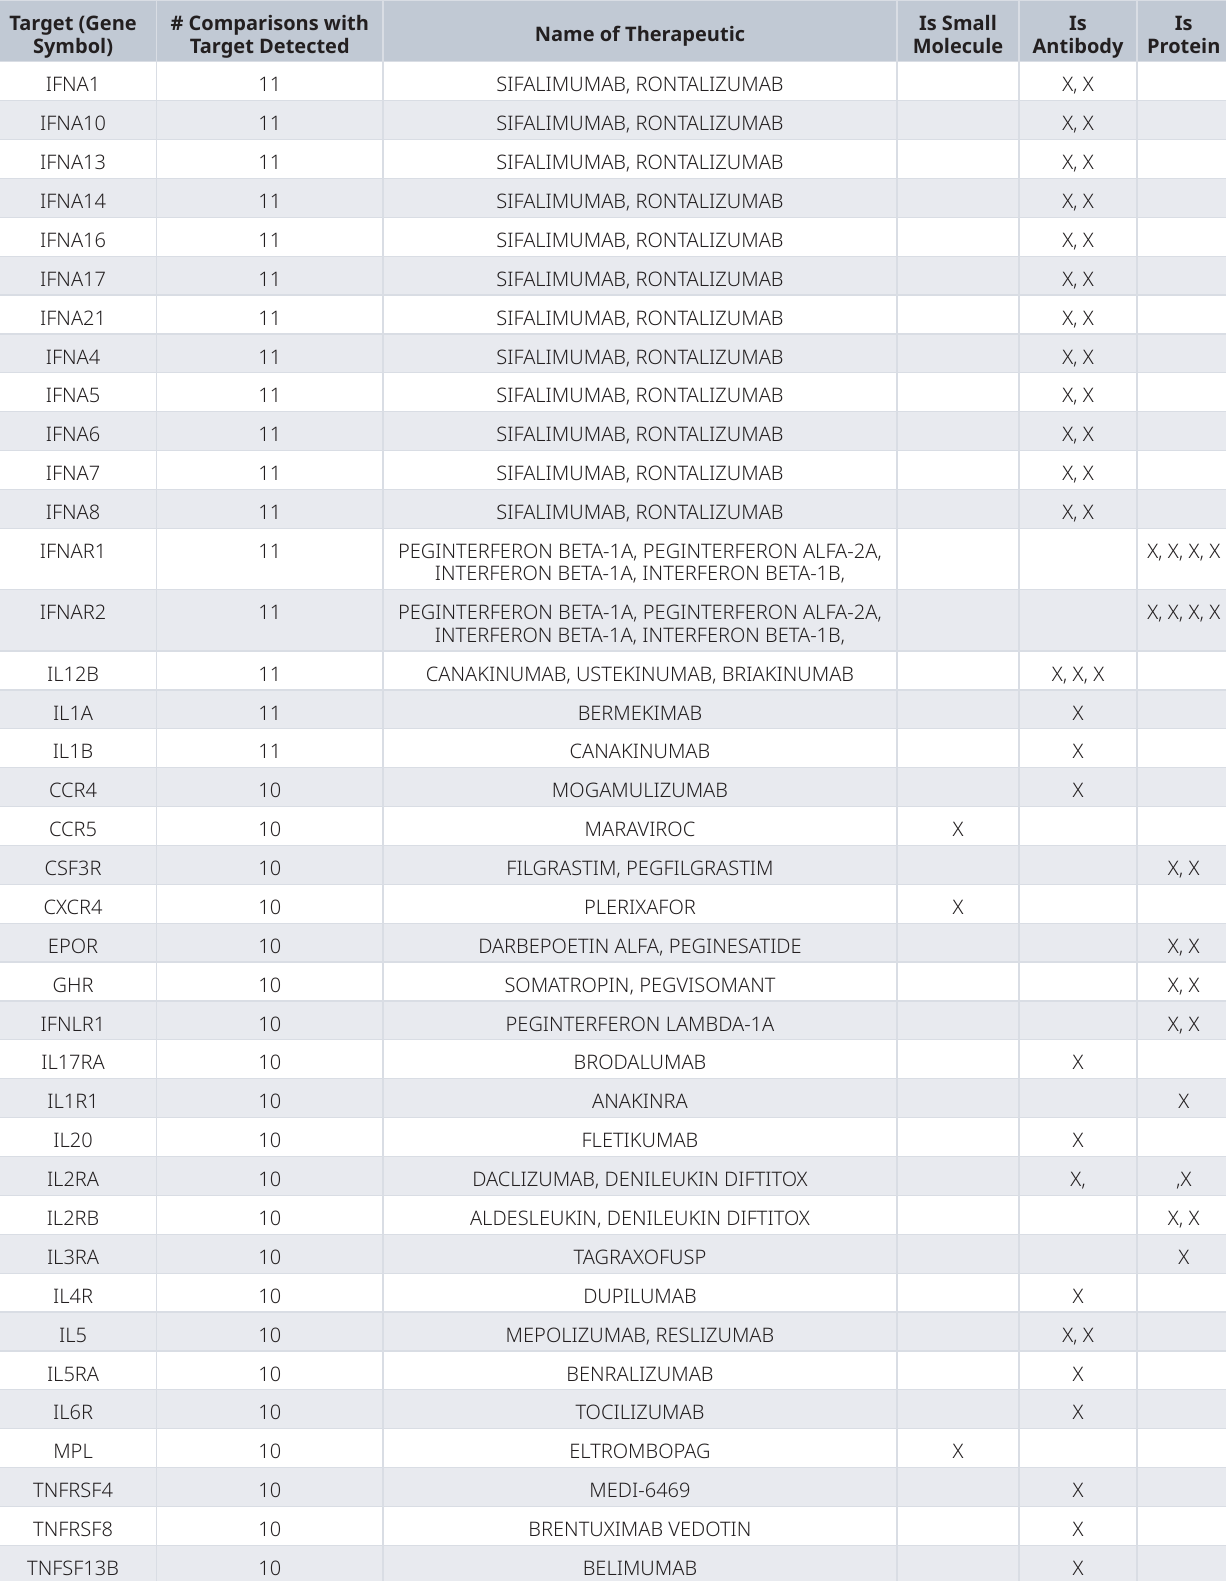
X: indicates the type of each therapeutic. Drug types against the same target are indicated with